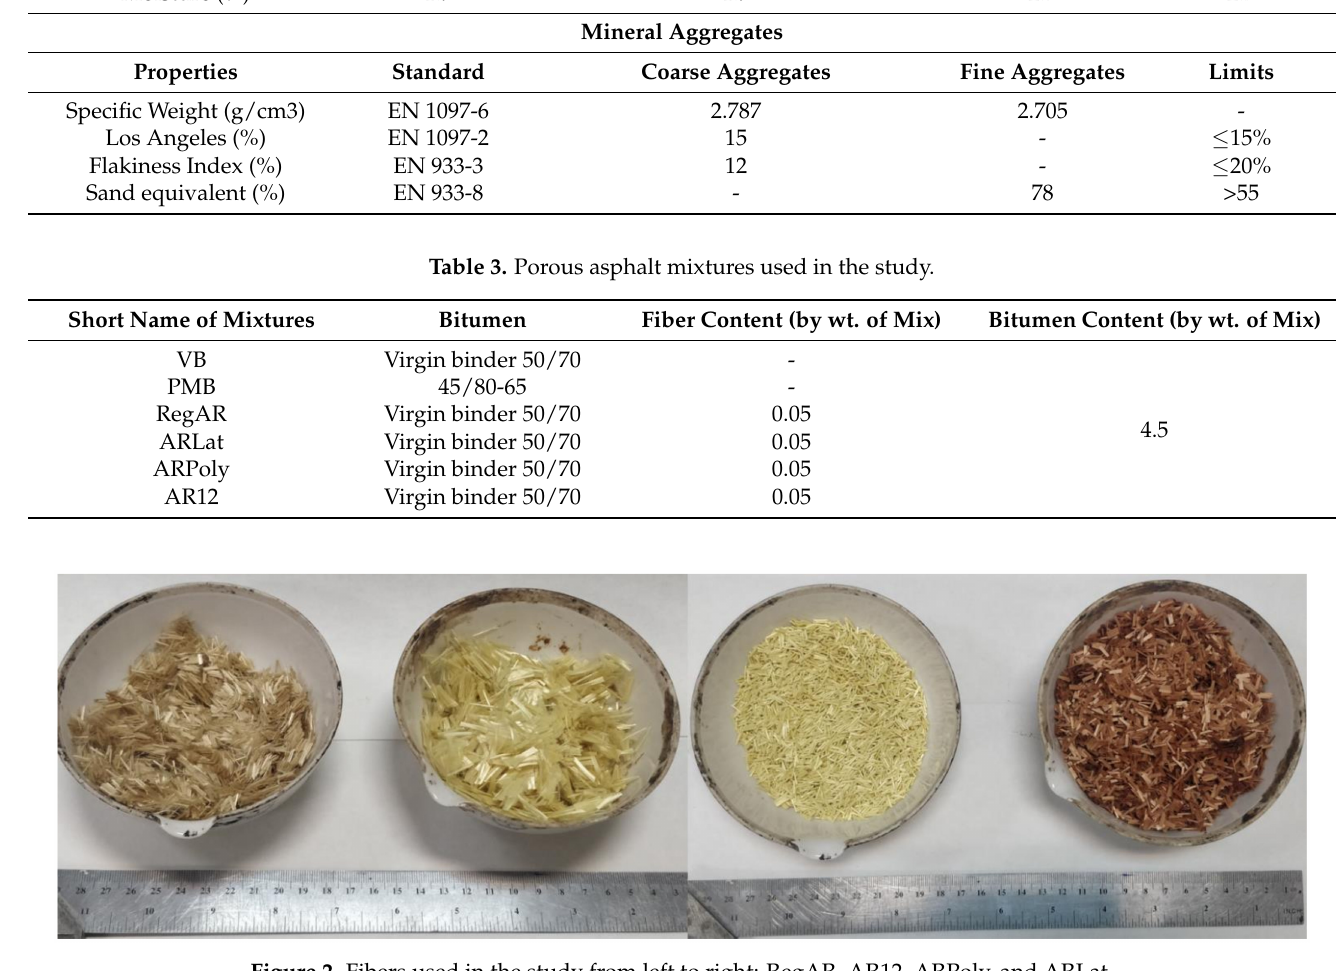
Figure 2. Fibers used in the study from left to right: RegAR, AR12, ARPoly, and